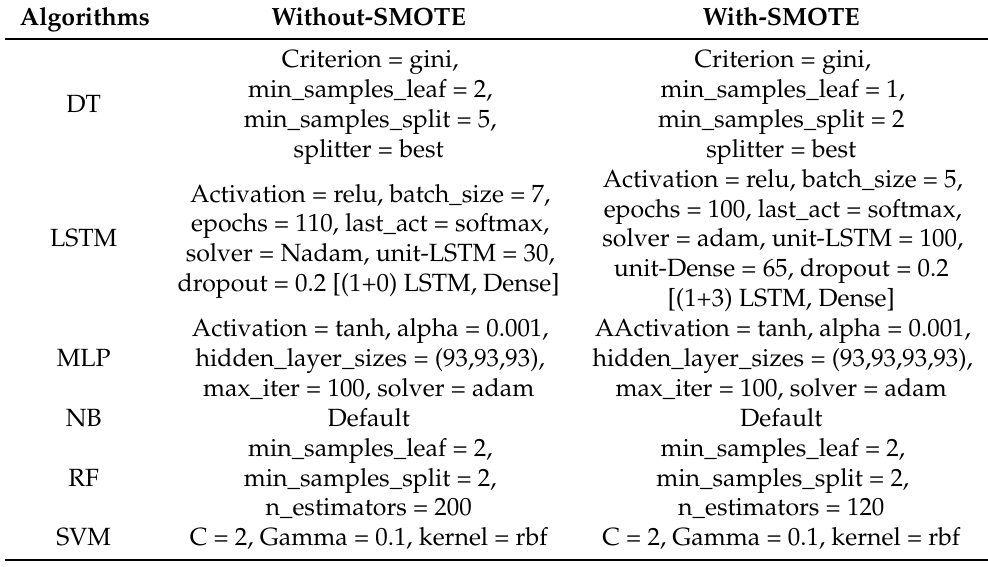
Table 7. Exp2 Scores (Precision, Recall, F1-Score).